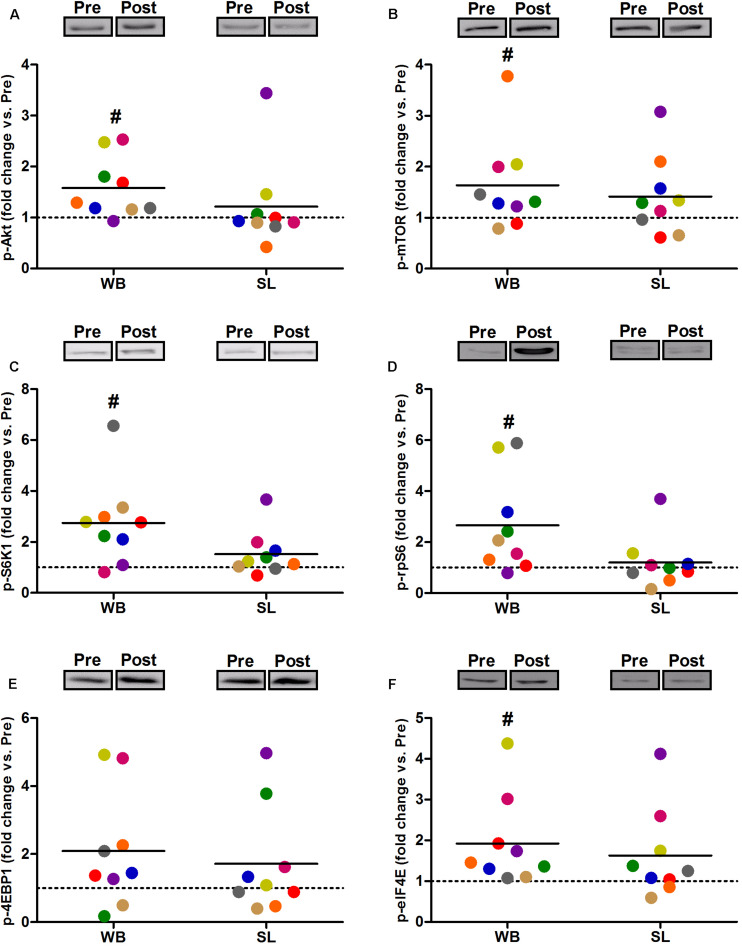
Changes in the phosphorylated state of Akt Ser473
(A), mTOR Ser2448
(B), S6K1 Thr389
(C), rpS6 Ser235/236
(D), 4EBP1 Thr37/46
(E), and eIF4E Ser209
(F) during whole body (WB) or single-leg (SL) heat stress. #Different compared with PRE within WB.